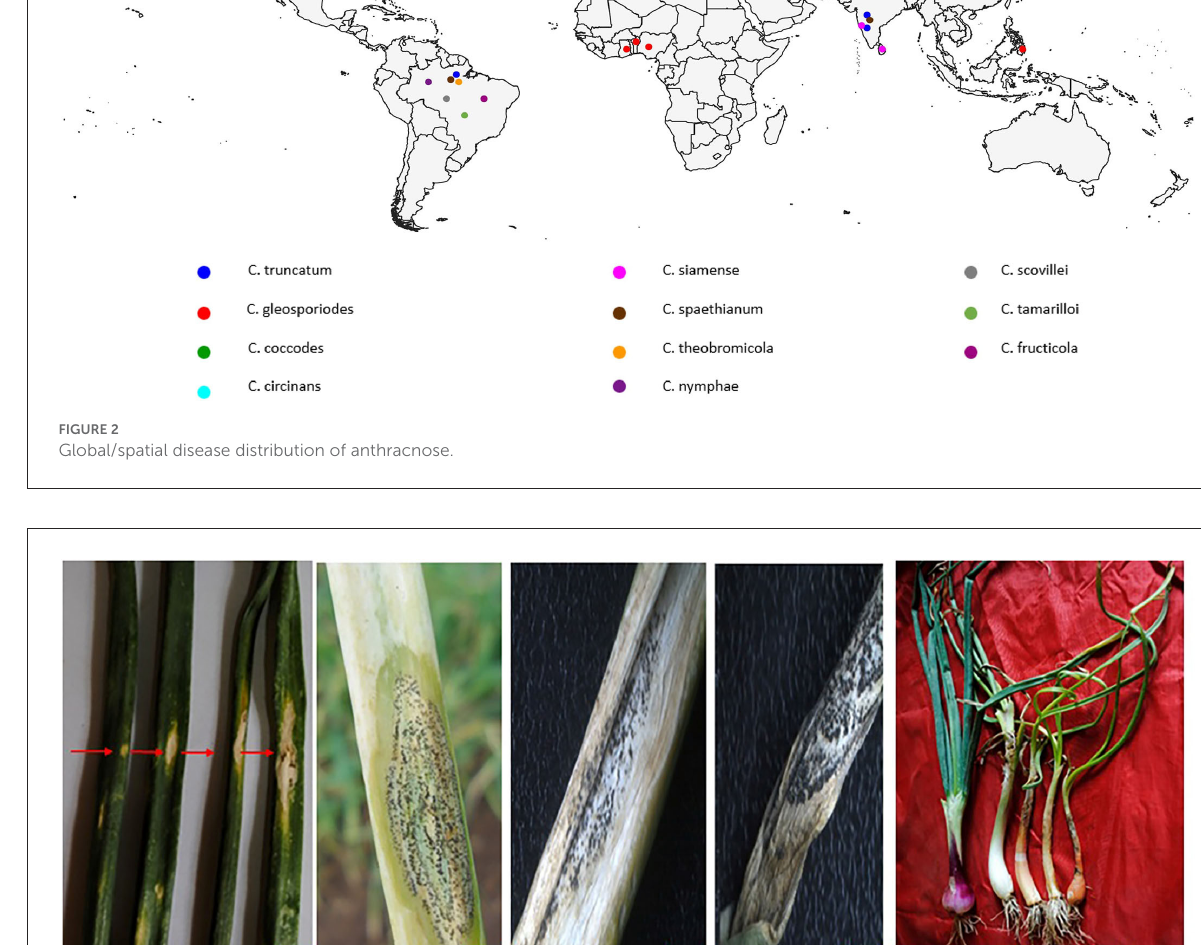
FIGURE3 Symptoms of Anthracnose-Twister. (a) Initial white sunken lesions on leaves enlarges to form straw color patches surrounded by chlorotic margin. (b) Lesion advancement with formation of black color, fruiting bodies (acervuli). (c) Necrotic tissues covered with acervuli. (d) Leaf twisting and necrosis (d) seedling chlorosis, neck elongation and twisting with undersized bulbs. Red arrows indicate lesion